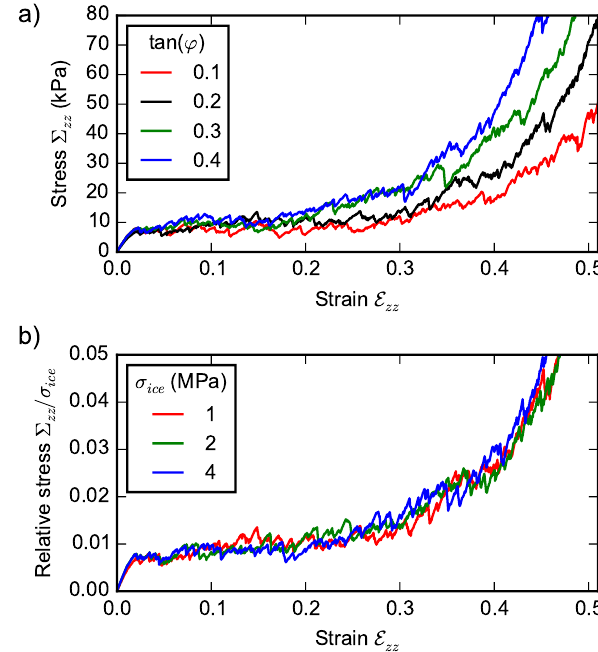
Figure 7. Simulated stress–strain curves for different sphere sizes (a) and number of grains (b) . In (b) , the images with 397, 668, 857 and 1132 grains were obtained with the segmentation parame- ter (κ t ,c t ) set to ( 1 . 3 , 0 . 08 ) , ( 1 . 3 , 0 . 16 ) , ( 1 . 0 , 0 . 25 ) and ( 0 . 7 , 0 . 5 ) , respectively.